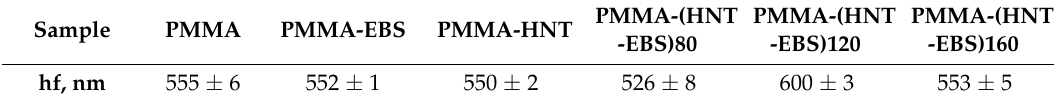
Table 1. The residual depth after final unloading (final depth) for PMMA and PMMA/HNT nanocomposites.